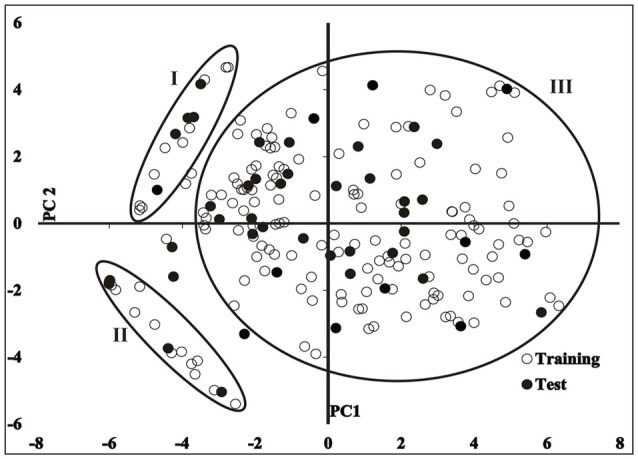
A plot between first two principal components (PC) illustrating descriptor space of 166 training set (hollow circles) and 41 test set (filled circles).